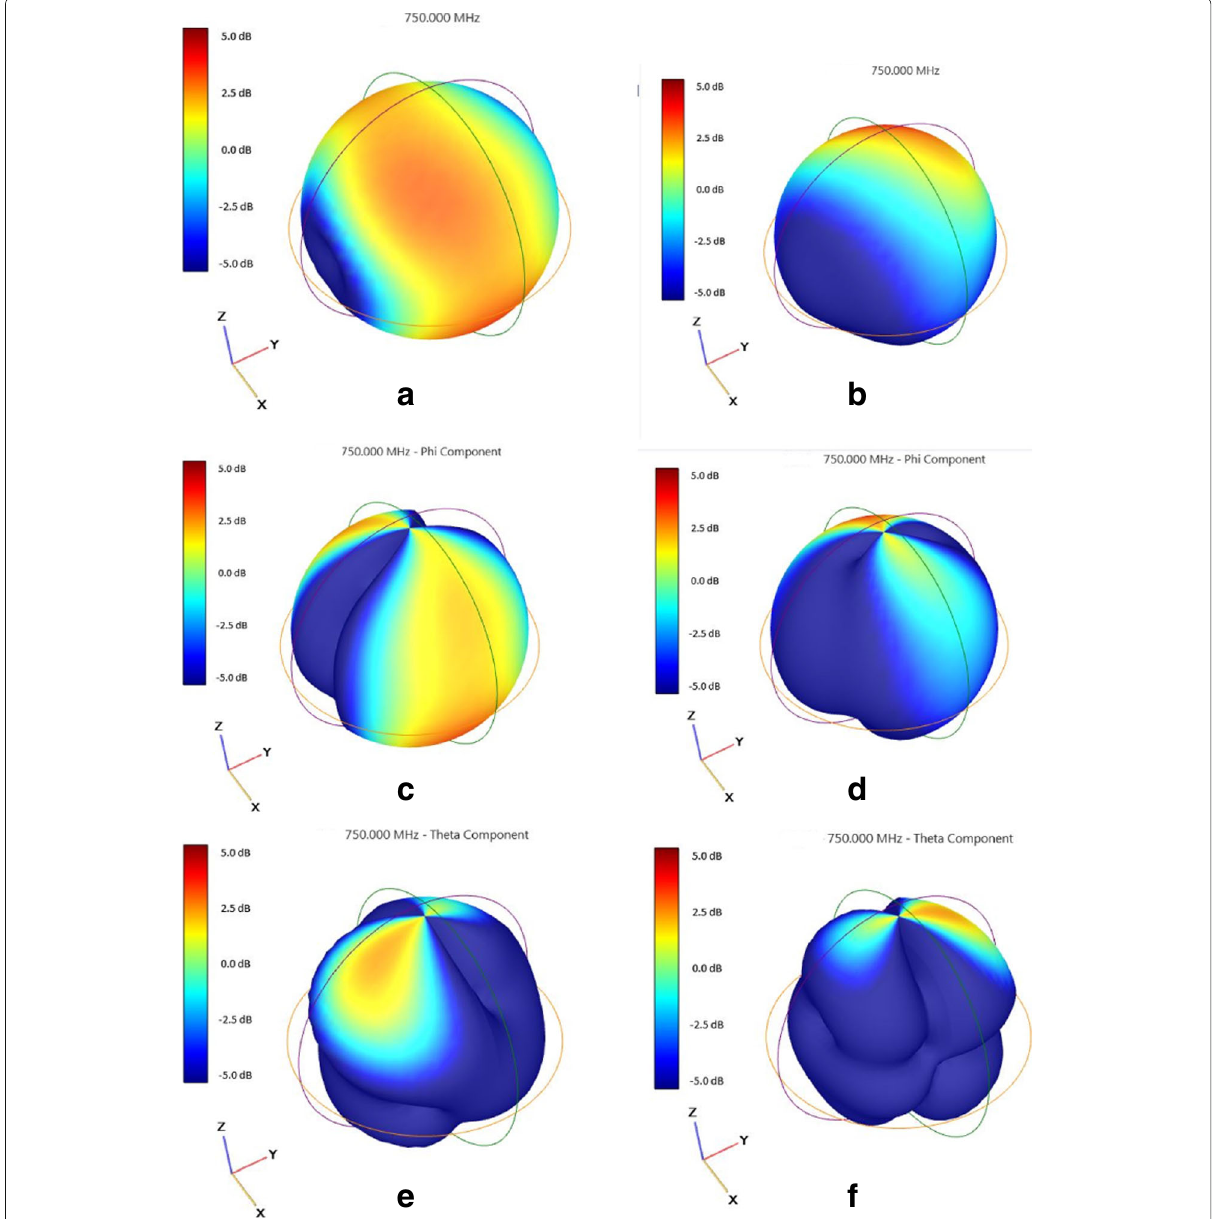
Fig. 2 Typical popular smart phone antenna directivity plots: a total directivity of main antenna, b total directivity of diversity antenna, c phi-polarized directivity of main antenna, d phi-polarized directivity of diversity antenna, e theta-polarized directivity of main antenna, and f theta-polarized directivity of diversity